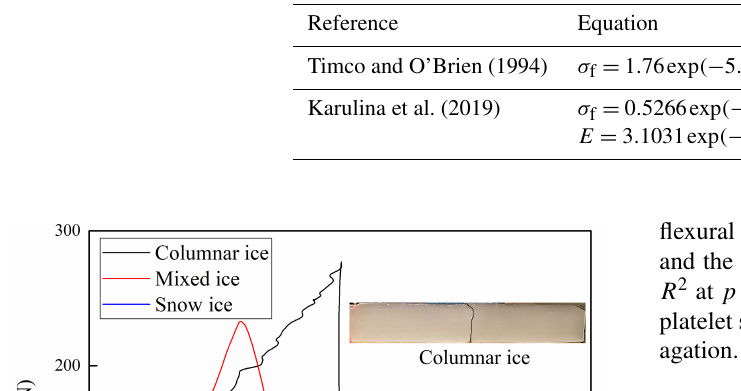
Table 2. Empirical relationships of flexural strength and effective modulus of elasticity based on brine volume fraction ( v b ). σ f is inMPa and E is inGPa.